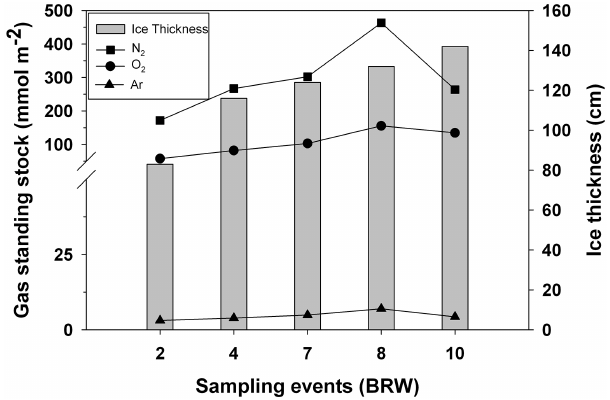
Figure 3. Evolution of the standings stocks of N 2 , O 2 and Ar (squares, circles and triangles respectively) compared to the evo- lution of sea ice thickness (vertical grey bars). The break in gas standing stocks is set at 50mmolm − 2 .